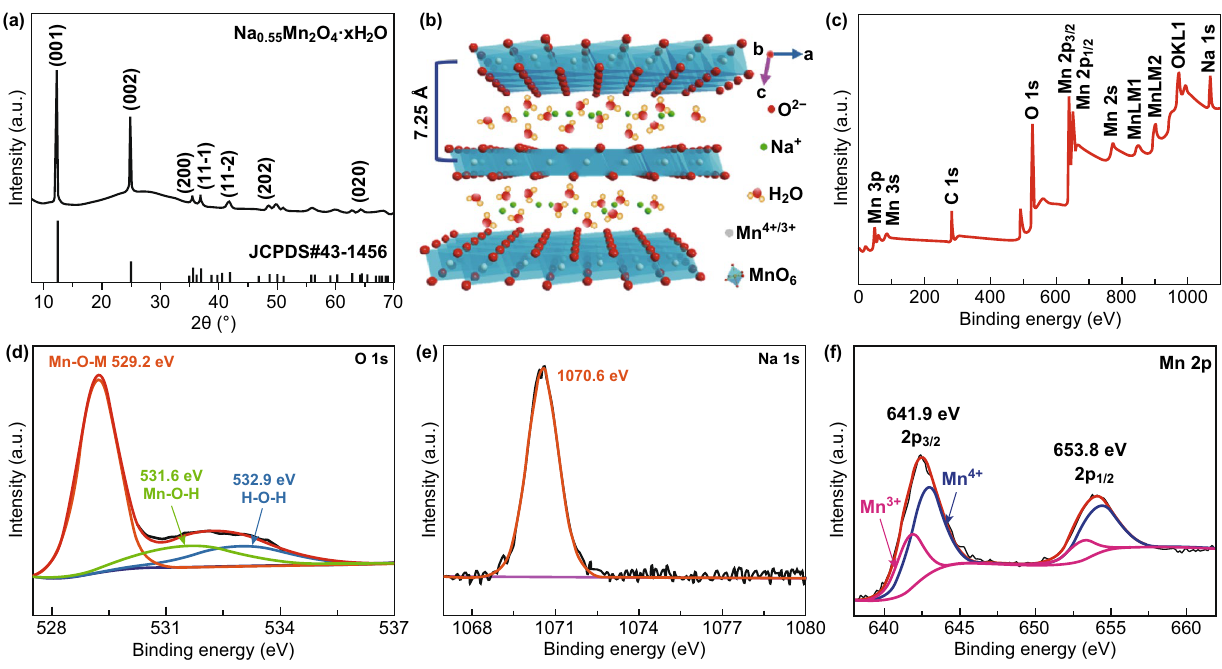
Fig. 1 a XRD pattern of NMOH. b Illustration of crystal structure of Na 0.55 Mn 2 O 4 · x H 2 O. XPS spectra of NMOH: c survey scan, d O 1 s spec‑ trum, e Na 1 s spectrum, and f Mn 2 p